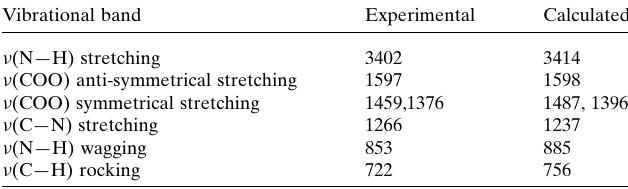
Table 2 Some selected experimental and calculated wavenumbers (cm (cid:5) 1 ).